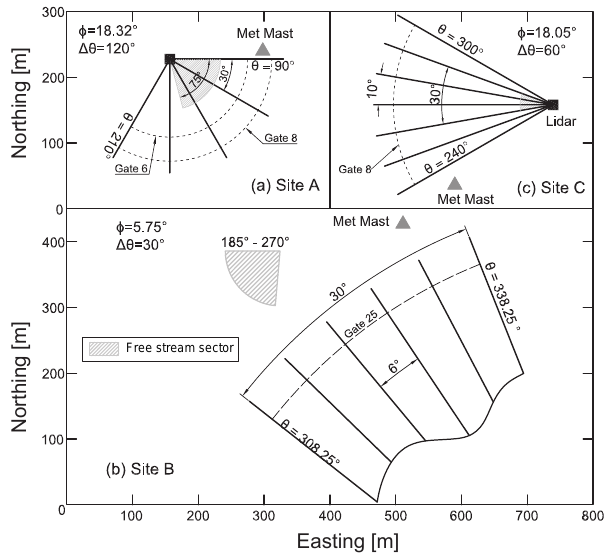
Figure 5. Plan views of the scanning geometries used at (a) Site A, (b) Site B and (c) Site C. The dark squares indicate the lidar lo- cations, and the hatched areas indicate the wind direction sectors without flow distortions. Locations of meteorological masts are de- noted by the solid gray circles. The elevation angle ( φ ) and the arc span ( (cid:49)θ ) used at each of the sites are also given.